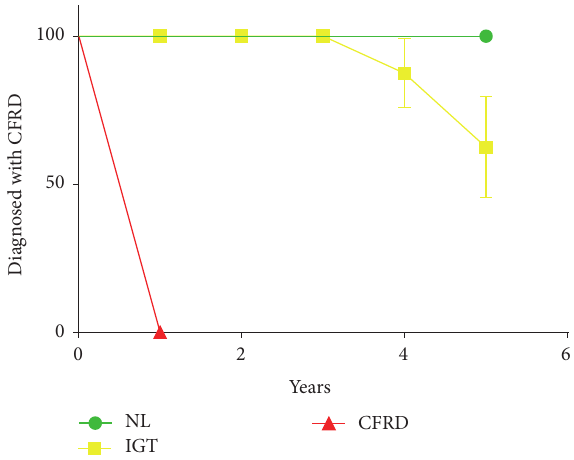
Figure 3: Abnormal CGM results predict the development of guideline criteria diagnosed glucose abnormalities over time. CGM results were categorized as normal (green circles), impaired (yellow squares), or consistent with CFRD (red triangles). Time to event was analyzed using the Log-rank (Mantel-Cox) test. 0/1 subjects with normal CGM, 3/11 subjects with impaired glucose metabolism, and 5/5 subjects with CFRD by CGM were subsequently diagnosed with CFRD. ( 𝜒 2 = 17.27 , DF = 2, 𝑝 = 0.0002